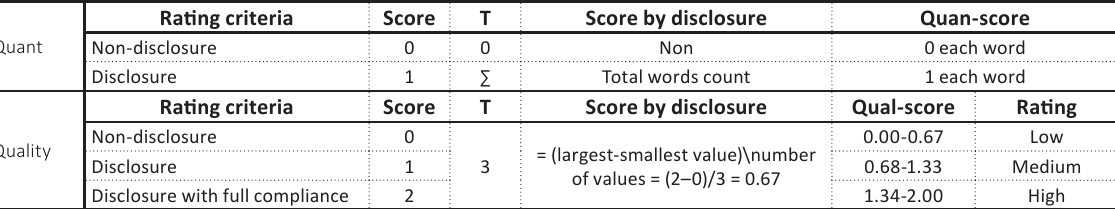
Table 1. Rating and scoring criteria of qualitative and quantitative information